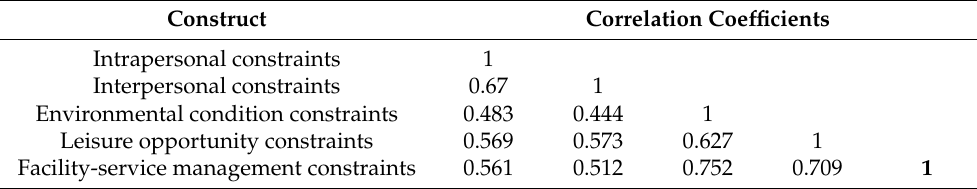
Table 4. Test for the convergent and discriminant validity of the latent